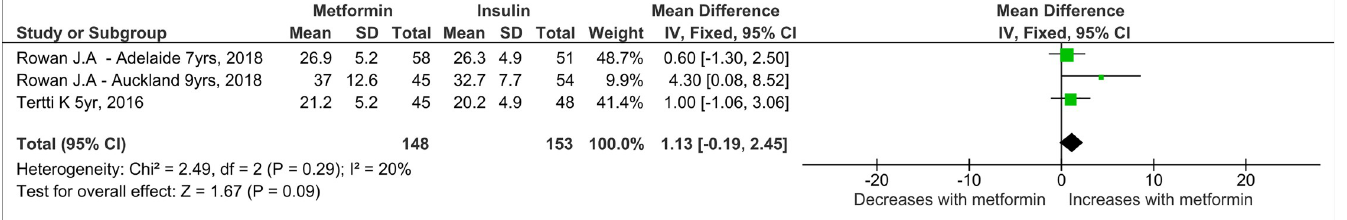
Fig 13. Childhood weight. Expressed as mean differences (fixed effects model) and 95% CI. IV, mean difference.